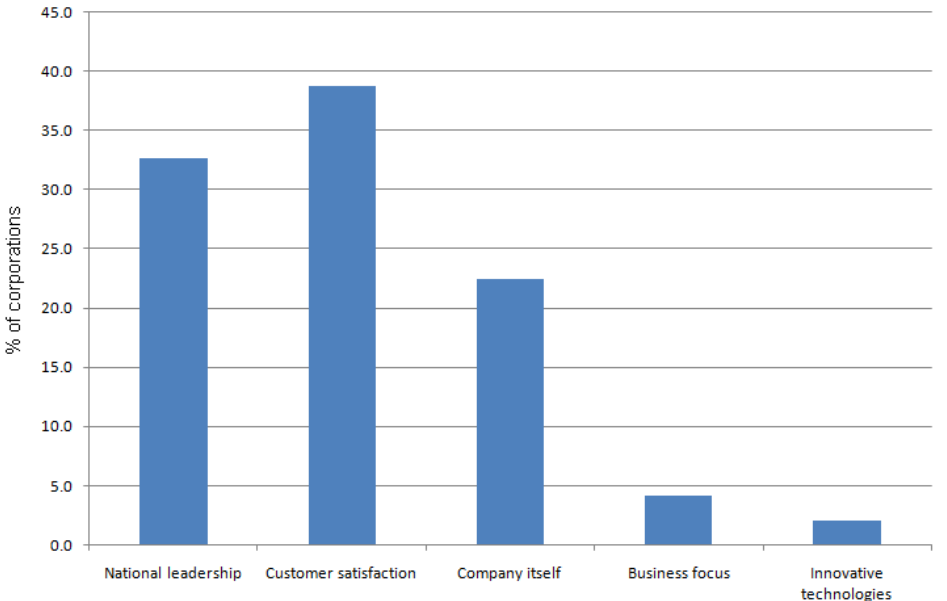
Figure 3. General themes of the corporate web positioning of the considered Russian agricultural corporations.